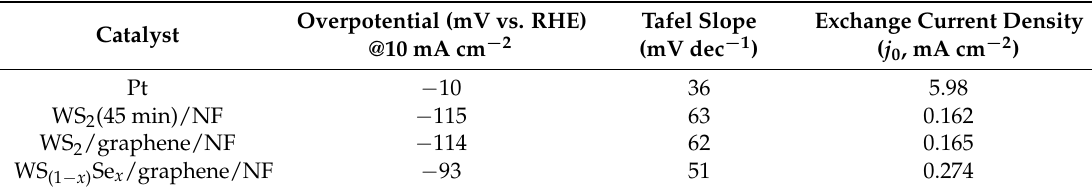
Table 1. Comparison of catalytic parameters of different HER catalysts.